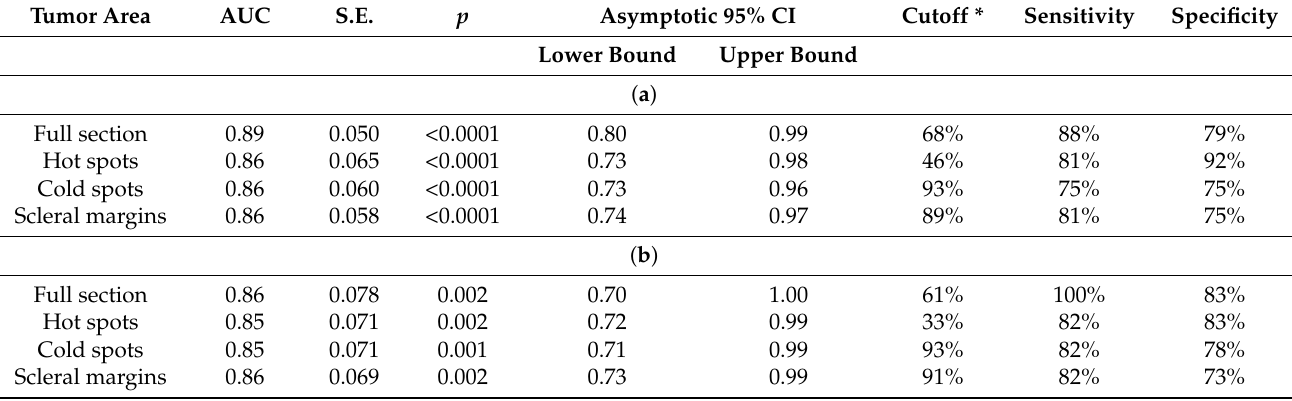
Table 2. ( a ). Receiver operating characteristics for the number of BAP-1 negative cells in relation to metastasis of uveal melanoma. * Optimal cutoff for proportion of BAP-1 negative tumor cells in given area. S.E., standard error. C.I.,